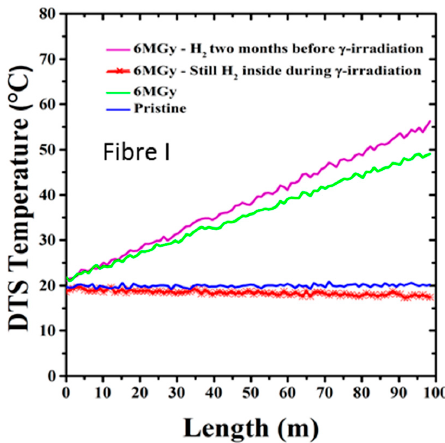
Figure 18. Distributed Temperature measurement performed on Fiber I, at room temperature. Results of pristine (light blue line), γ -irradiated at 6 MGy (red line), γ -irradiated at 6 MGy with H 2 inside (green line) and γ -irradiated at 6 MGy two months after H 2 -loading (blue line) samples are shown.